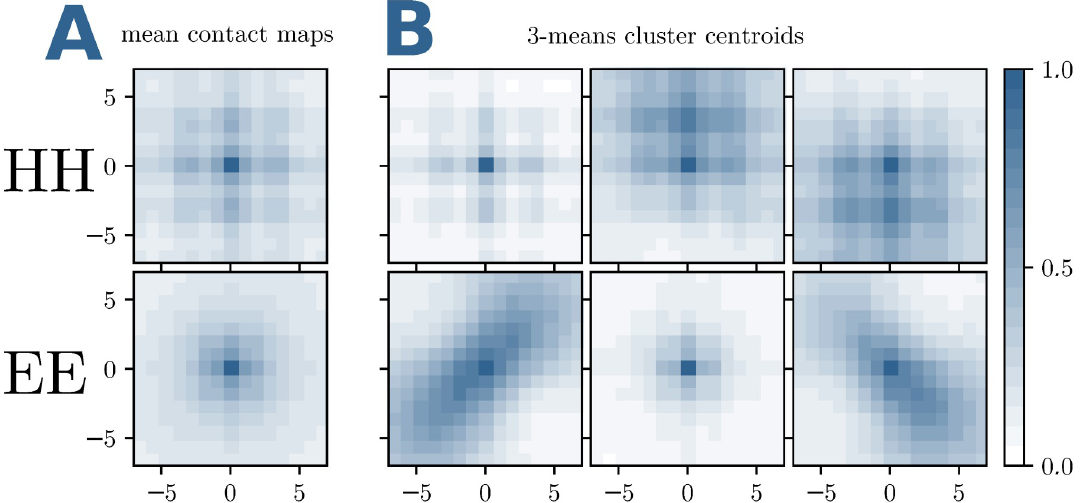
Fig 1. Typical patterns in inter-domain contact matrices. (A) The frequencies of contacts in a 15 × 15 contact-map window around an HH or EE contact are displayed. The average is done over the 46978 HH and 12281 EE contacts of the training set. The mean contact matrices are a combination of parallel, anti-parallel or mixed HH and EE contacts. (B) We disentangle them with a k -means clustering with k = 3. The 6 resulting centroids, 3 for a central HH inter-domain contact (upper row) and 3 for an EE contact (lower row), show pronounced patterns and can be used to filter DCA